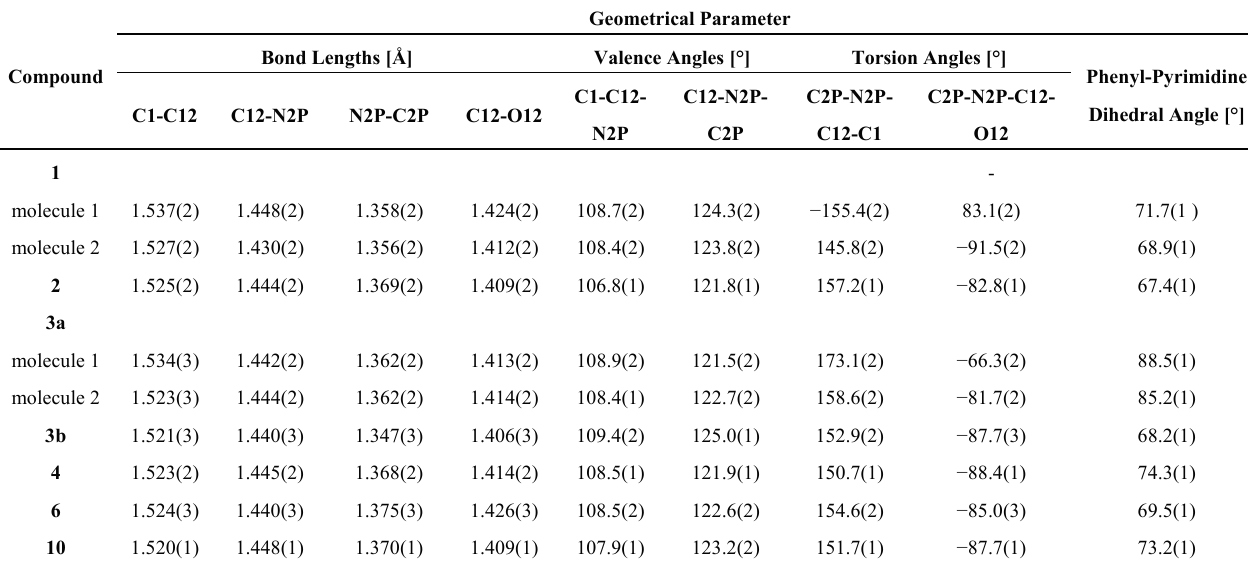
Table 1. Selected geometrical parameters for crystalline hemiaminals ( 1 , 2 , 3a , 3b , 4 , 6 , 10